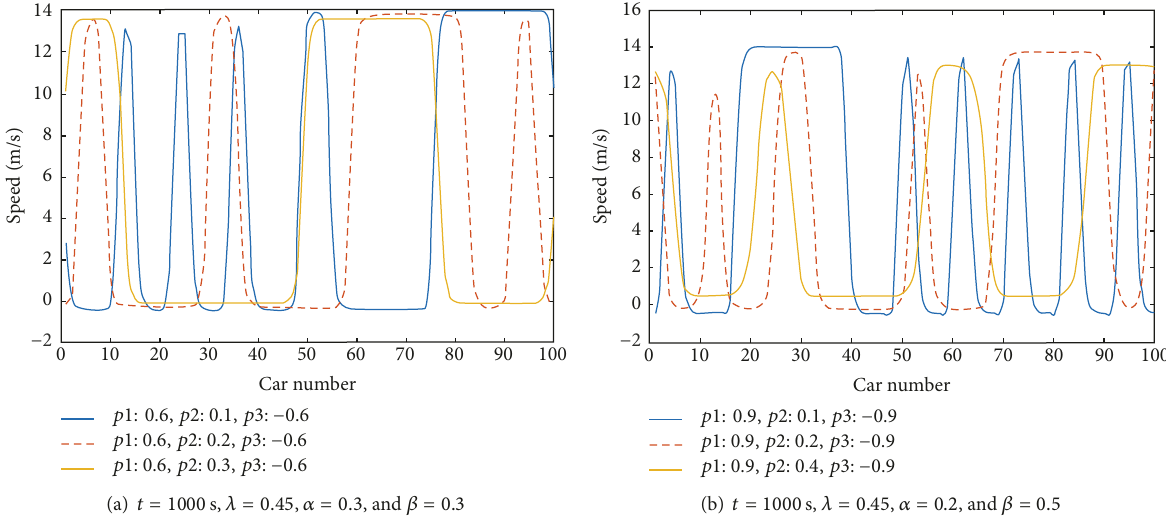
Figure 10: Snapshot of the velocities of all vehicles with different 𝑝 1 , 𝑝 2 , 𝑝 3